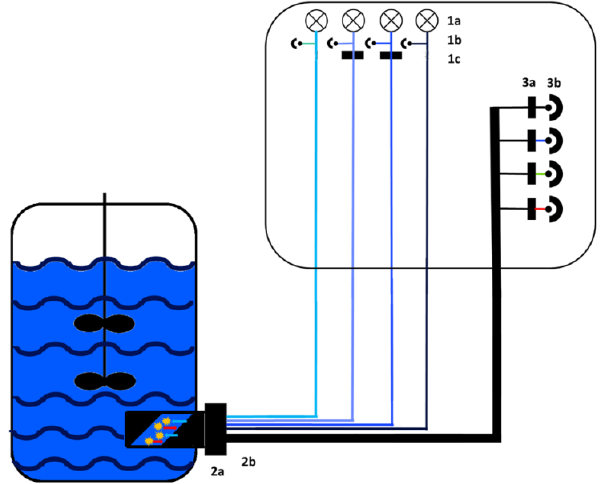
Figure 1. Experimental set-up of the sensor. Excitation: 1a: 278nm LED (Laser Components GmbH, Munich) and 365, 450 and 850nm LED (Roithner Lasertechnik GmbH, Vienna), 1b: photodiodes for each LED as reference and 1c: bandpass filter with a central wave- length (CWL) of 365 or 450nm (Edmund Optics GmbH, Karlsruhe; FWHM 10nm). Light transport: 2a: adapter for the Ingold port, 2b: fibre probe with eight fibre bundles. Detection: 3a: bandpass filters with a CWL of 340 / 448 / 525nm (FWHM: 29 / 25 / 18nm) or a cover for scattered light; 3b: photodiodes (Advanced Photonix,